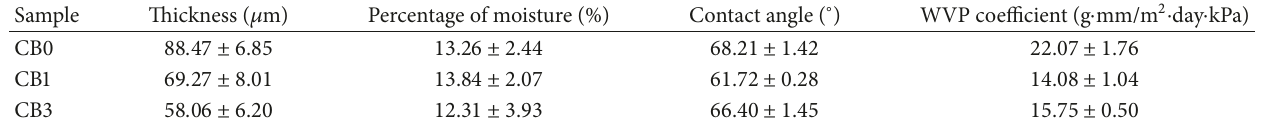
Table 2: Thickness, moisture content, contact angle, and water-vapor permeability coefficients of the membranes. Sample